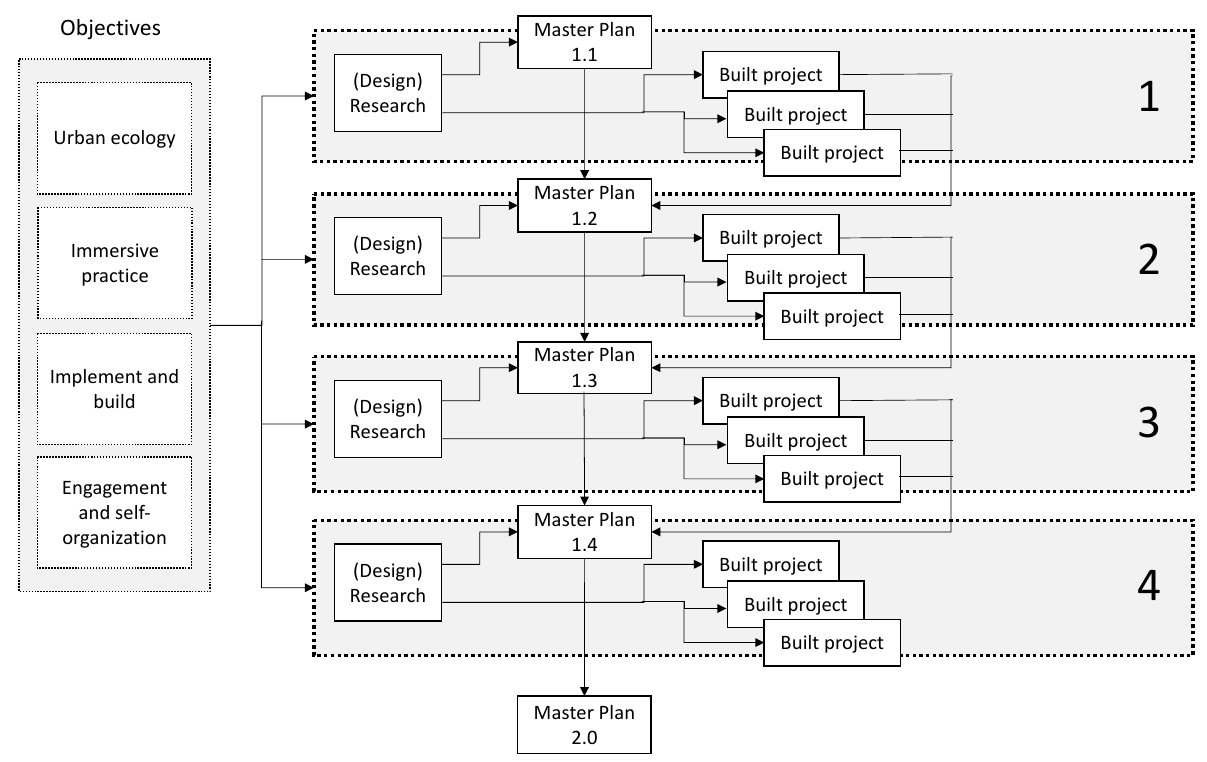
Figure 1. Methodology: integration of four general objectives in a yearly process of design research, master planning and building/implementing ecological projects.